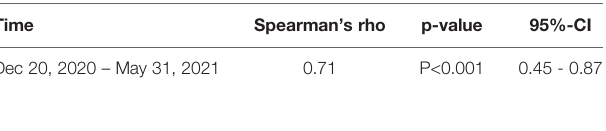
TABLE 2 | Correlation for weekly queries per 10 million searches and in fl uenza vaccination rates. Time